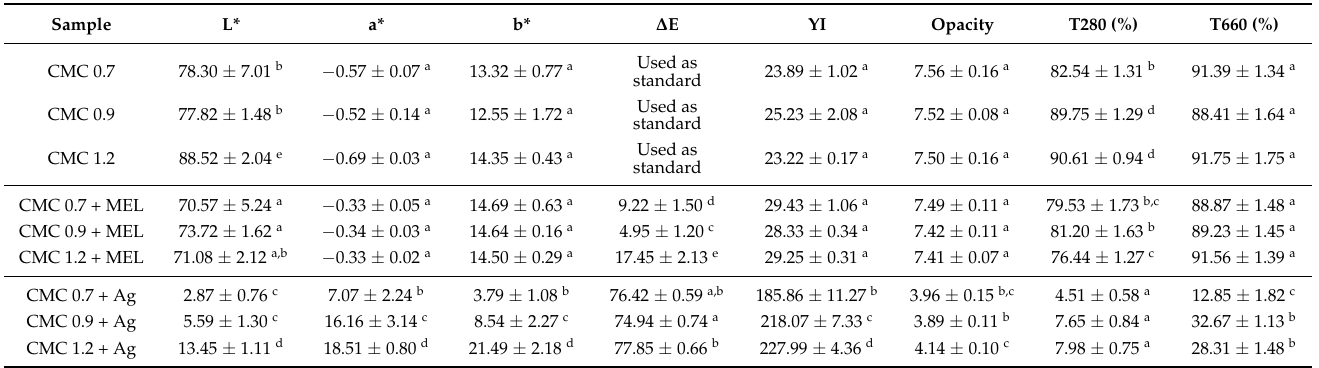
Table 2 . Color (L*, a*, b*), total color difference ( Δ E), yellowness index (YI) and transmittance of Table 2. Color (L*, a*, b*), total color difference ( ∆ E), yellowness index (YI) and transmittance of unmodified and modified CMC films. unmodified and modified CMC films.